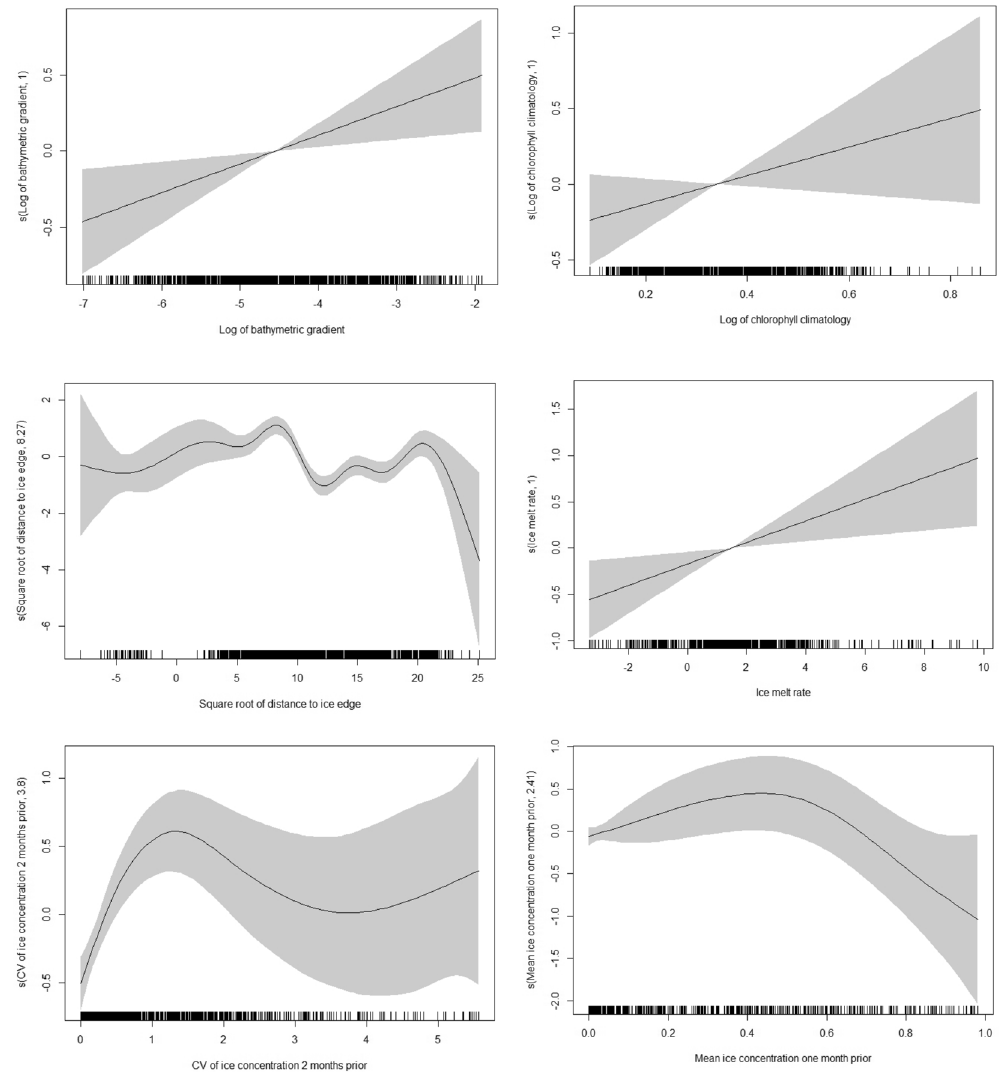
Figure 3. Smooths of generalized additive mixed modelling. (GAMM) terms showing the influence of environmental variables on whale ‘search’ behaviour ( b ). Locations of observations are shown as tick marks on the x -axes. Solid lines are the estimates of the smooths, grey areas indicate standard errors of the estimated smooths. The y-axis indicates the effect of the smooth function of each covariate upon the probability of being in ‘search’ behaviour; with a lower (higher) value indicating reduced (increased) probability. ( a ) Bathymetric gradient, ( b ) summer chlorophyll climatology, ( c ) distance to ice edge, ( d ) ice melt rate, ( e ) coefficient of variation (CV) of ice concentration two months prior, and ( f ) mean ice concentration one month